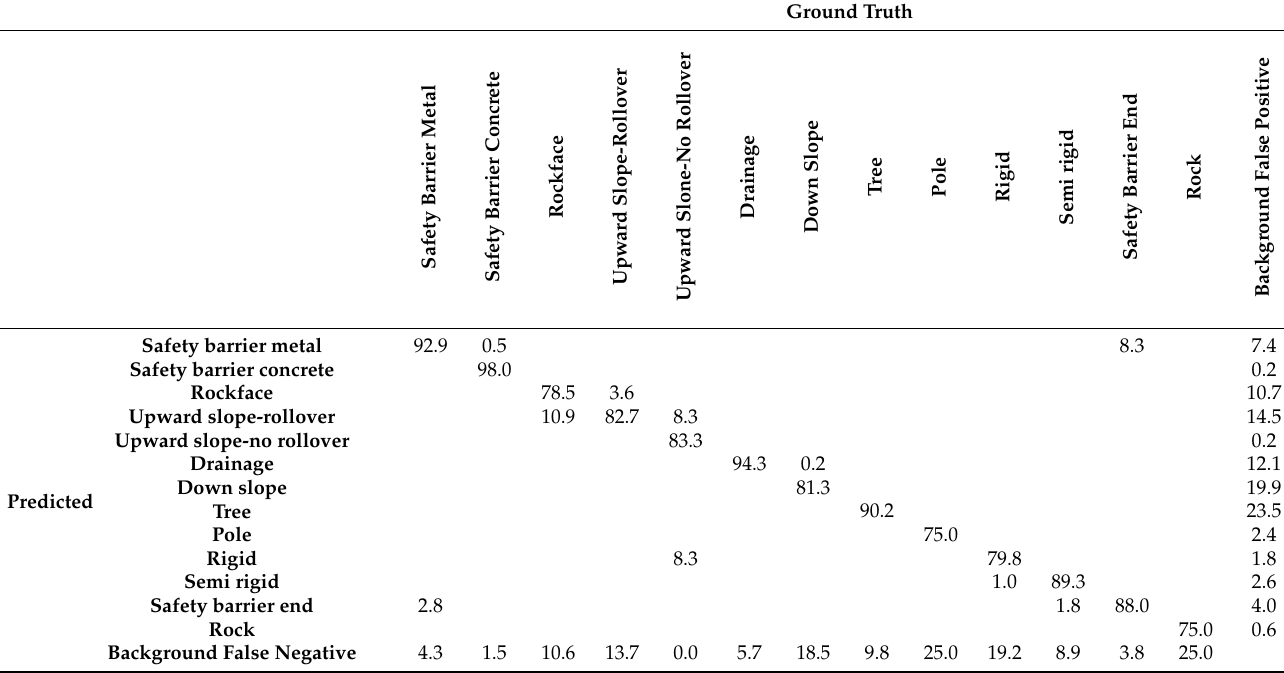
Table 2. Confusion matrix for predicted and ground truth objects presented with percentage. Ground Truth